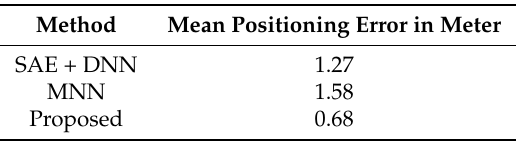
Table 2. Experimentation results on the